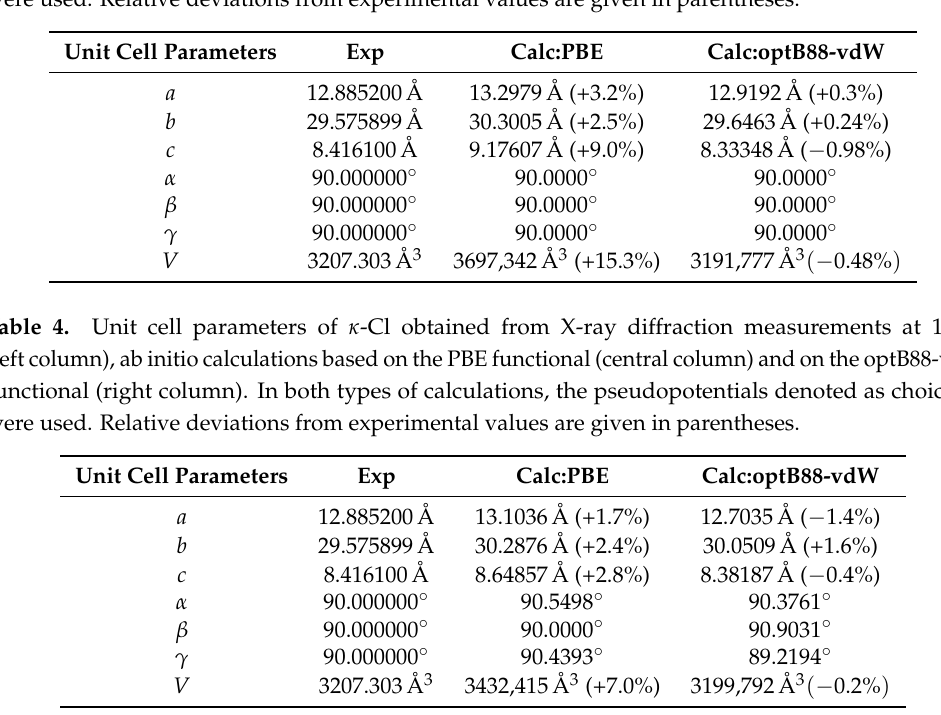
Table 3. Unit cell parameters of κ -Cl obtained from X-ray diffraction measurements at 100K (left column), ab initio calculations based on the PBE functional (central column) and on the optB88-vdW functional (right column). In both types of calculations, the pseudopotentials denoted as choice (1) were used. Relative deviations from experimental values are given in parentheses.